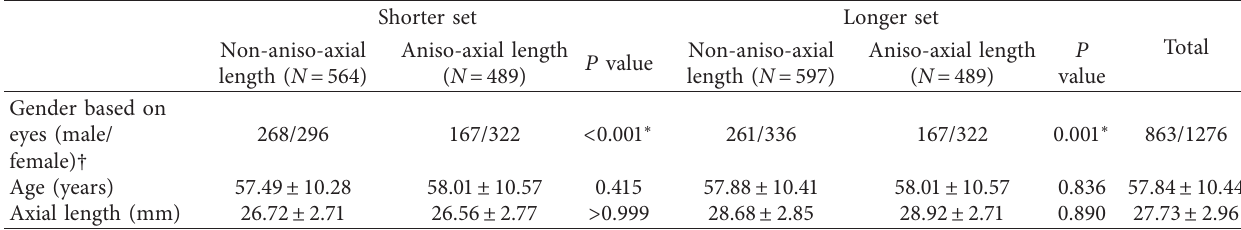
Table 1: Demographic data of patients included in the study.